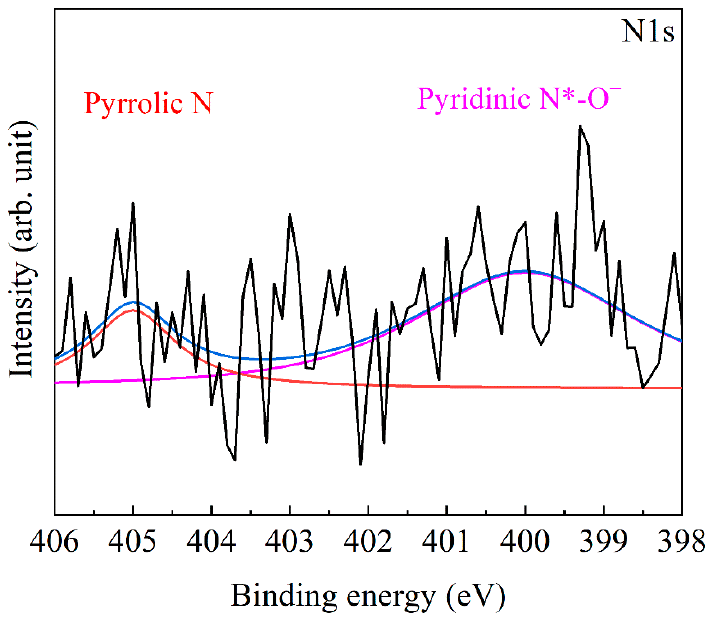
Figure 6. XPS spectrum of APPJ-coated polydopamine on GF.